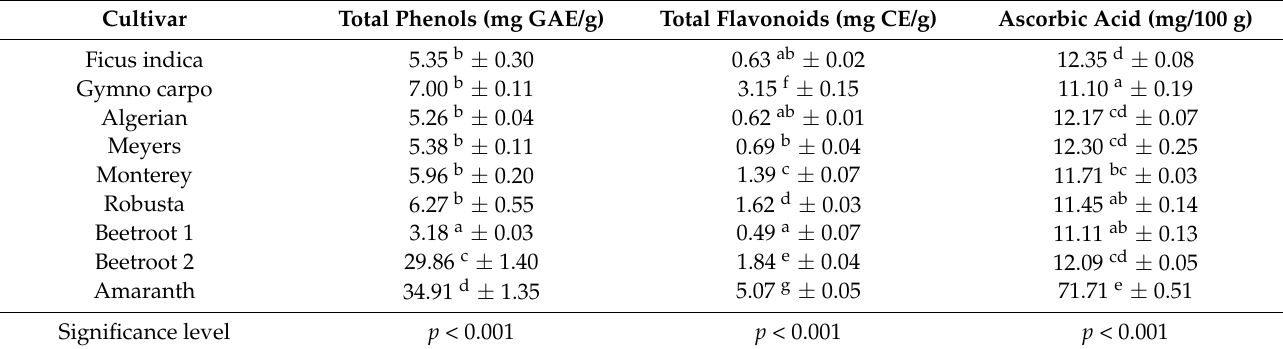
Table 1. Content of antioxidants in different